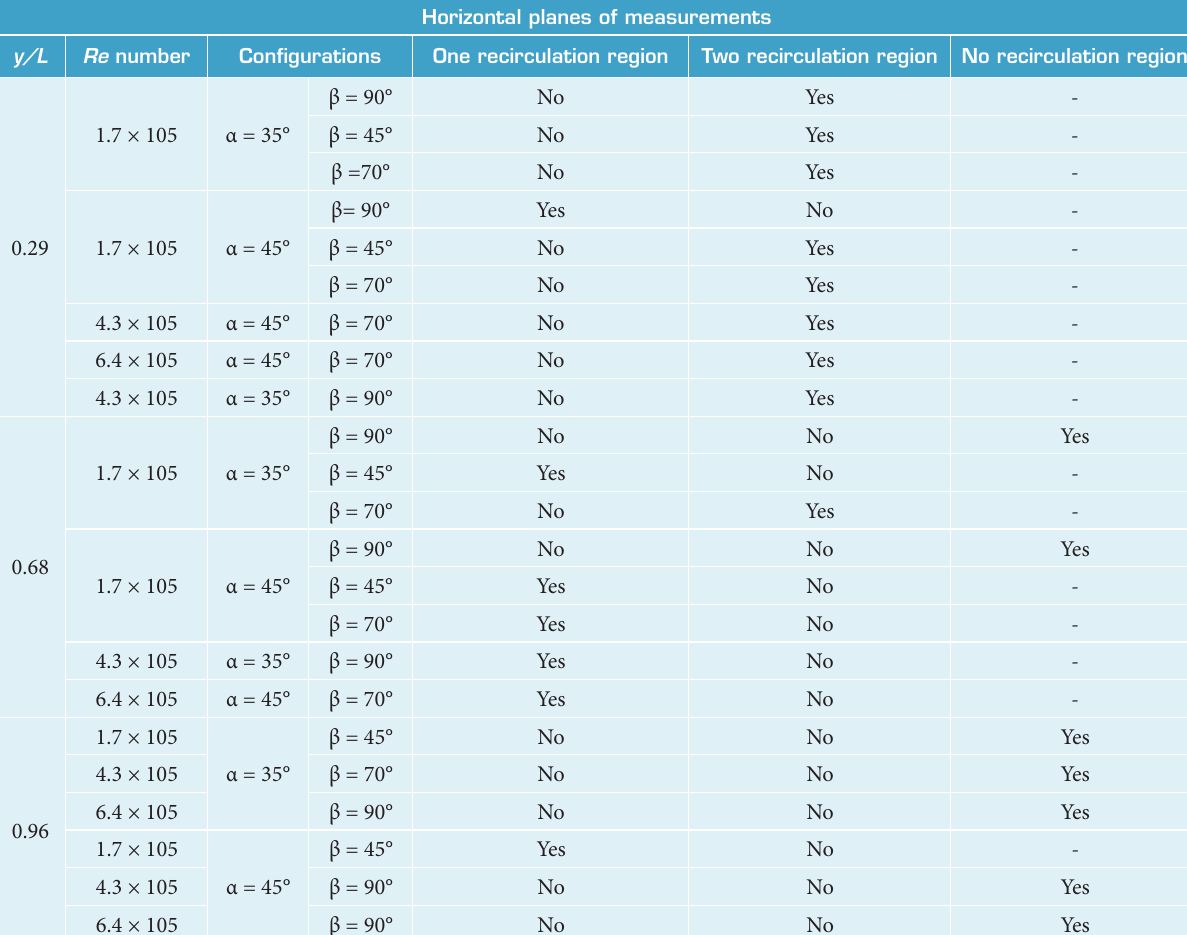
Table 2. Flow pattern characteristics in horizontal planes of measurements in the launch vehicle